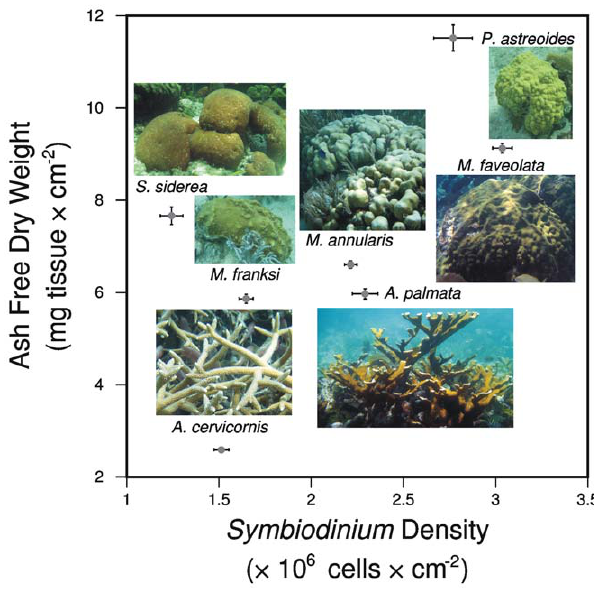
Figure 2. Species-specific values for tissue biomass versus Symbiodinium density from seven species of scleractinian corals. Biomass was measured by ash-free dry weight in mg tissue 6 cm 2 2 whereas Symbiodinium density was quantified as cells 6 10 6 6 cm 2 2 . Data presented as mean values 6 standard error. A photograph of each coral species is provided for reference. Photo- graphs are not to scale. Photo credits: D.J. Thornhill, G.C. Chilcoat, and D.W. Kemp.